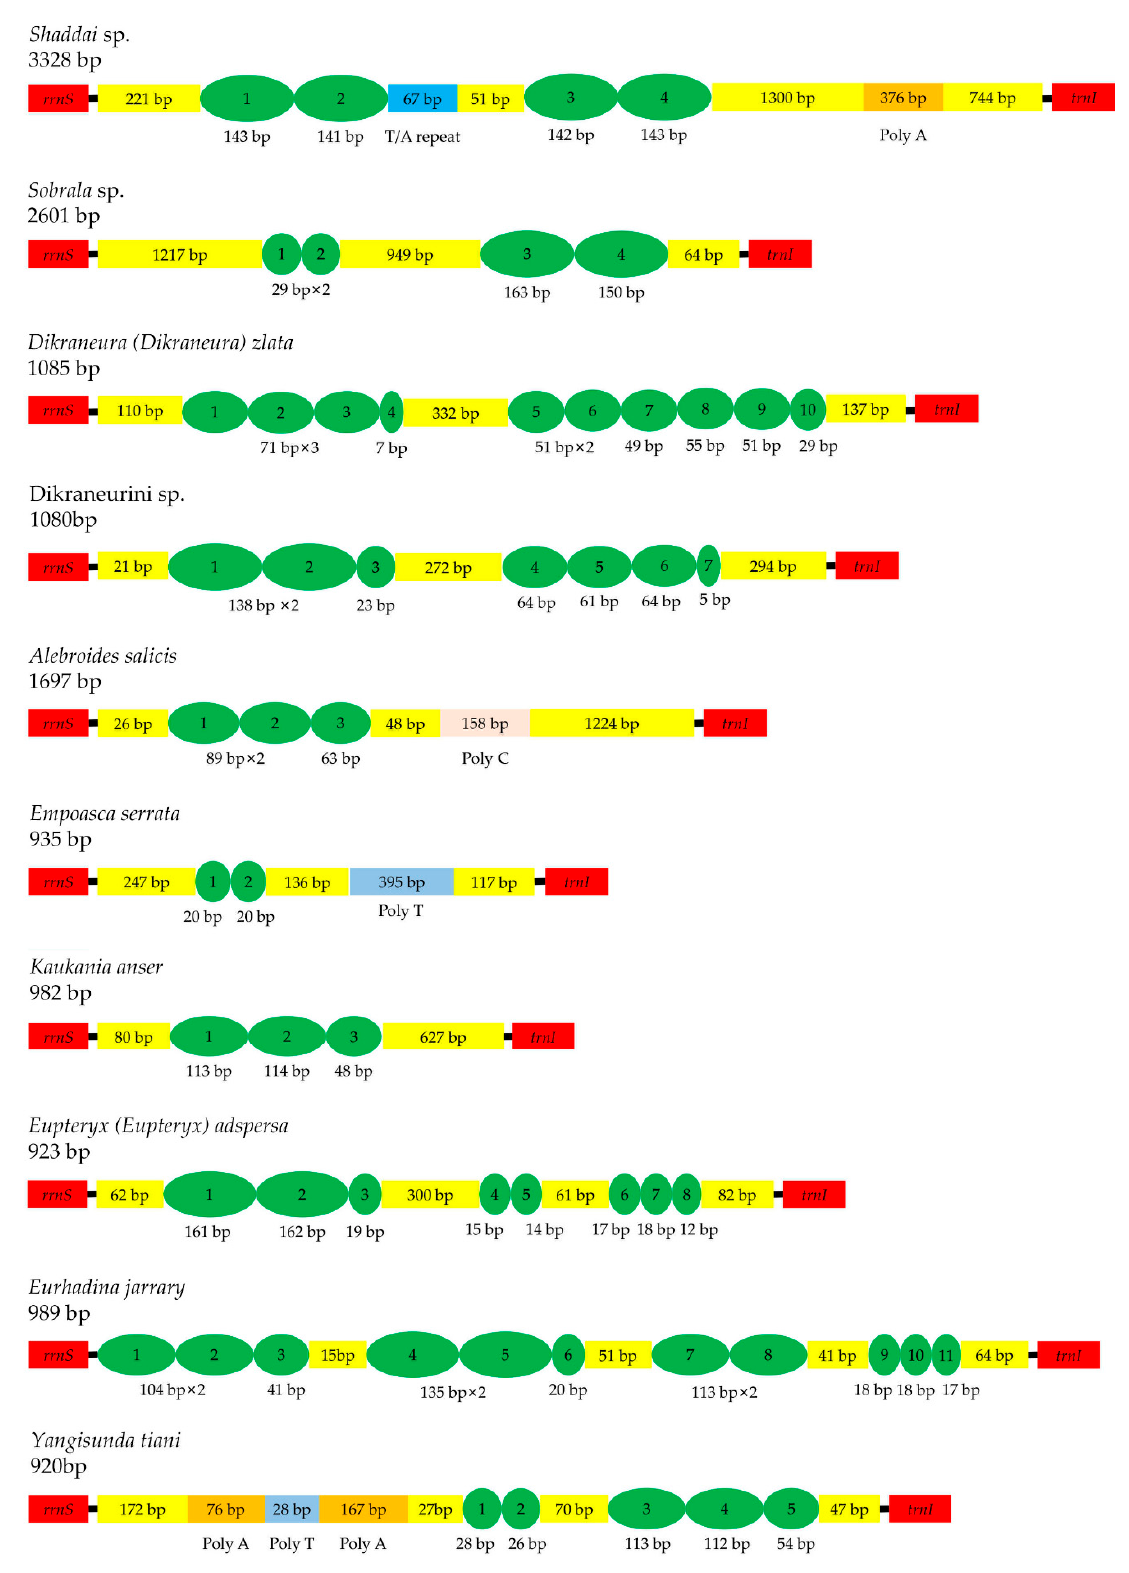
Figure 4. Organization of the control regions in the mitochondrial genomes of Shaddai sp., Sobrala sp., Dikraneura (Dikraneura) zlata, Dikraneurini sp., Alebroides salicis , Empoasca serrata , Kaukania anser , Eupteryx (Eupteryx) adspersa, Eurhadina jarrary and Yangisunda tiani . The green ovals indicate the tandem repeats; the yellow boxes indicate the non-repeat regions.